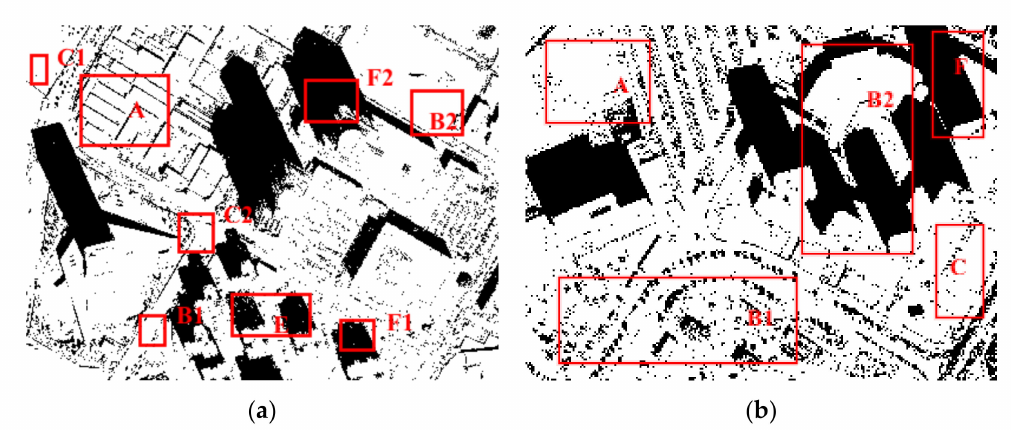
Figure 5. Reference images for test images of Tripoli, Libya. ( a ) Tripoli-1. ( b )